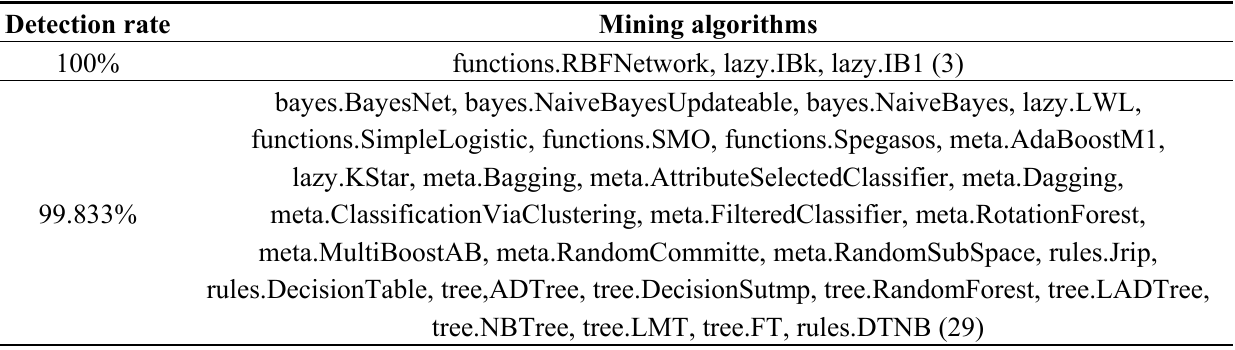
Table 3. SYN flood attack—mining results with ADTree selection